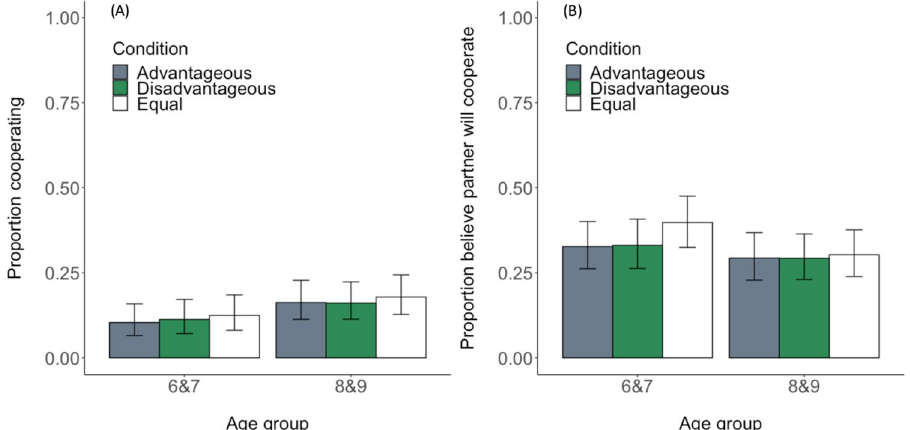
Figure 5. ( A ) Proportion of trials in which children cooperated in the Prisoner’s Dilemma Game across advantageous, disadvantageous, and equal conditions, and ( B ) proportion of trials in which children believed their partner would cooperate across advantageous, disadvantageous and equal conditions. Data are shown by age group. Error bars show confidence